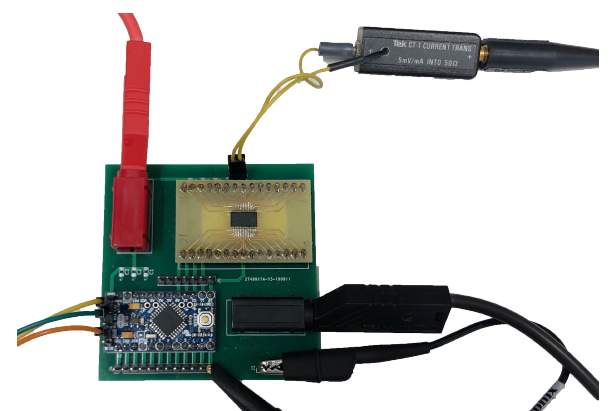
Figure 4: Measurement setup for acquiring power traces from a TMS37126 IC (on the yellow breakout board). Top-right: Tektronix CT-1 current probe. Bottom-left: Arduino Pro Mini functioning as a serial to SPI